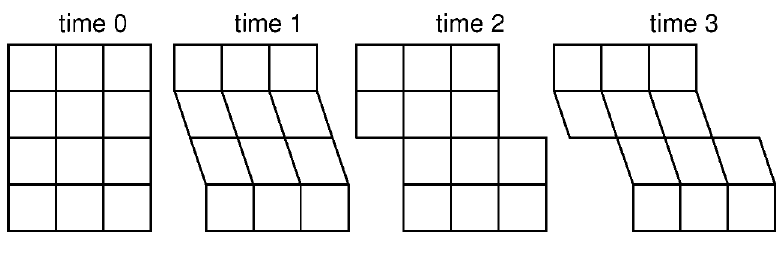
Fig. 4. A free-lagrange mesh motion